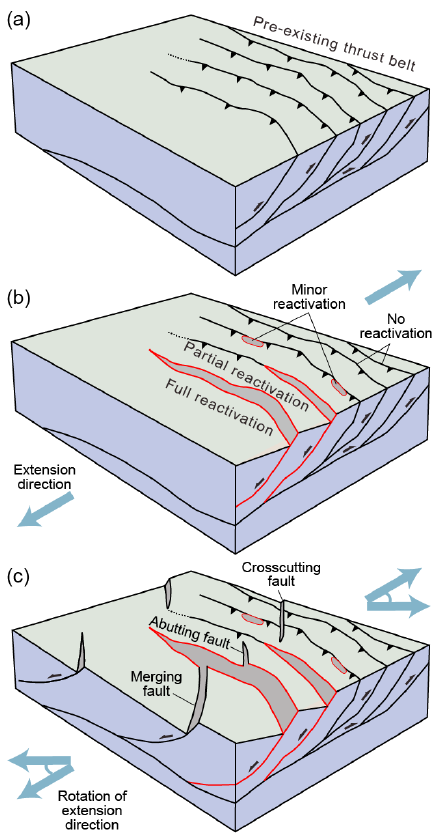
Figure 13. Synoptic figure showing how the presence of basement thrusting structures may influence the geometry and evolution of overlying rift system. (a) Pre-rift framework of thrusting structures within a crystalline basement. (b) Upon orthogonal extension those pre-rift thrusts act to control the reactivation extent, location and degree of faulting, and the basin boundary fault that occurs during rifting. (c) Subsequent rotation of extension direction produces a range of interactions with the rift-related faults, affecting the overall basin structures and